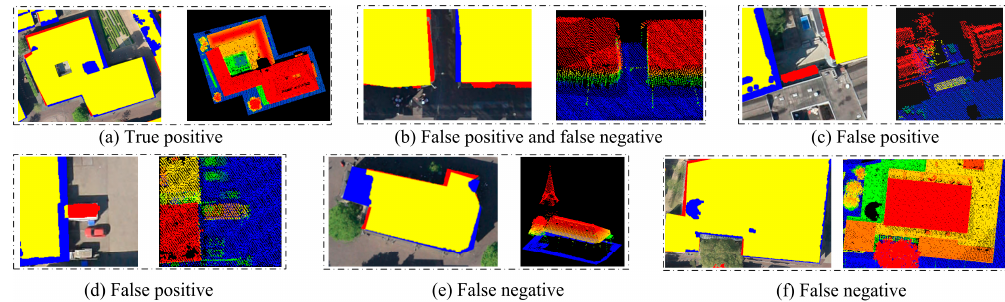
Figure 13. Six examples of the building detection results for Enschede data.